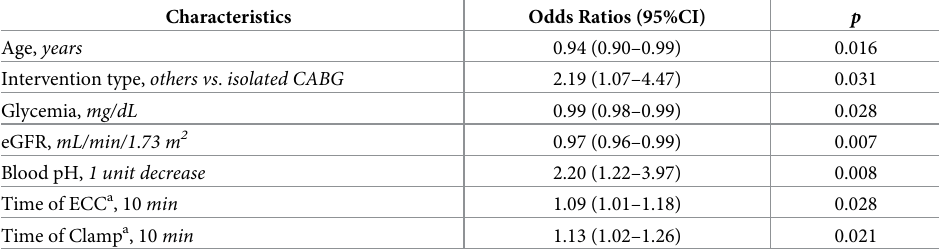
Table 4. Multivariable logistic regression analysis for determinants of acute kidney injury (AKI).